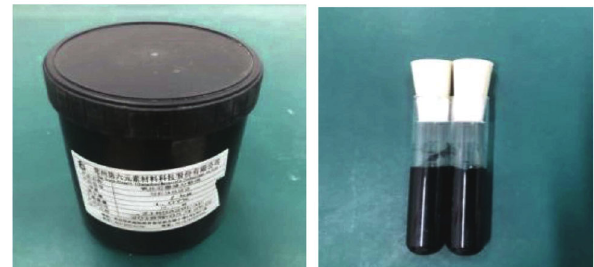
Figure 1: Dispersions of SE3522 GO.